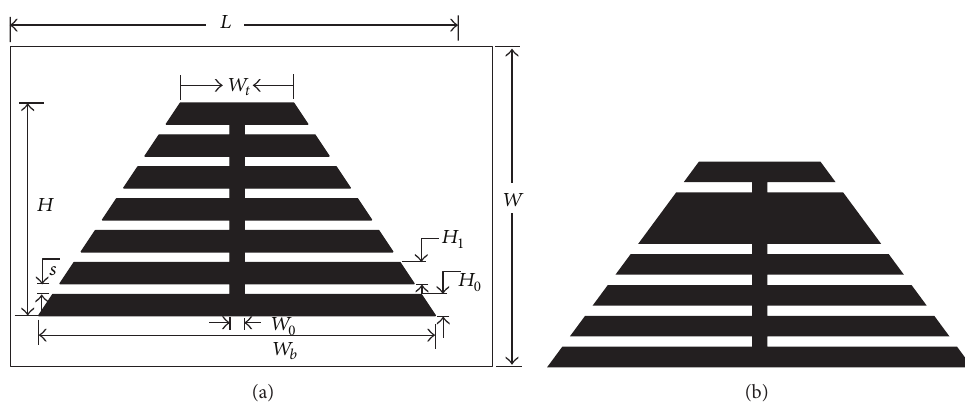
Figure 3: (a) Trapezoidal tag I with ID “111111” loaded with six pairs of slot resonators. (b) Trapezoidal tag II with ID “111101” loaded with five pairs of slot resonators.